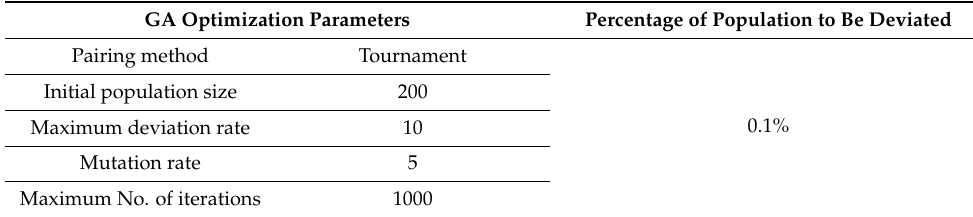
Table 2. Genetic algorithm parameters.